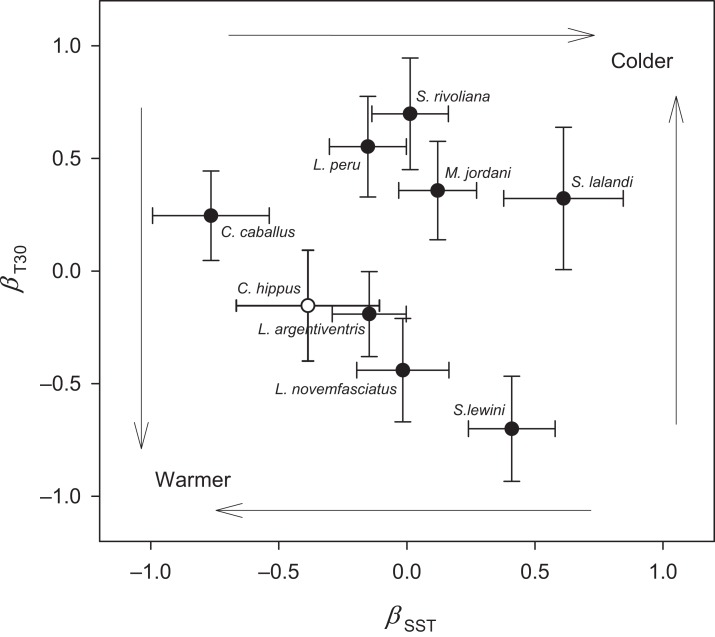
Ordination analysis of seamount fish species assemblages.Negative log likelihood parameter estimates of the two regressors, sea surface temperature (SST) and temperature at 30 m (T30), from logistic regression plotted on the plane γ = ρ + β + SST + βT30 revealed a spring (upper right) and fall (lower left) assemblage. Error bars represent standard error. Dark circles resulted from ordinal regression, and open circle resulted from nominal regression.